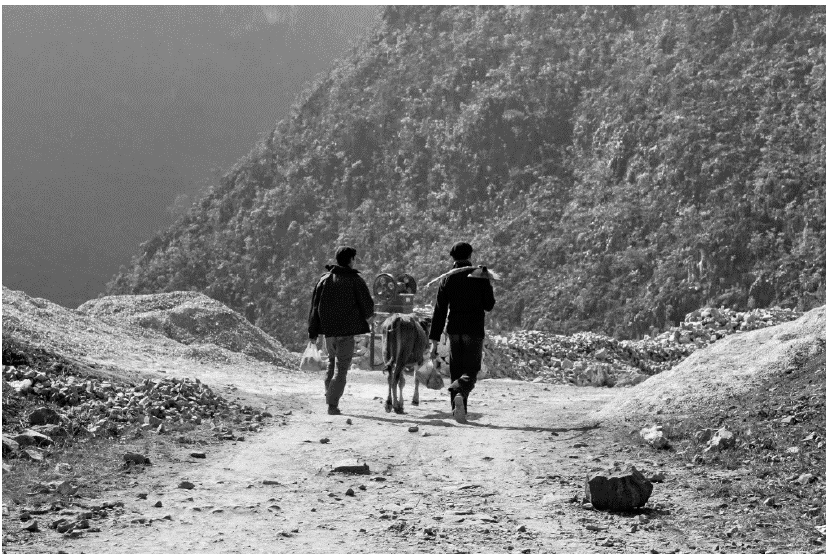
Figure 3. Dong Van Karst Plateau—© Thu-Ha Nguyen.